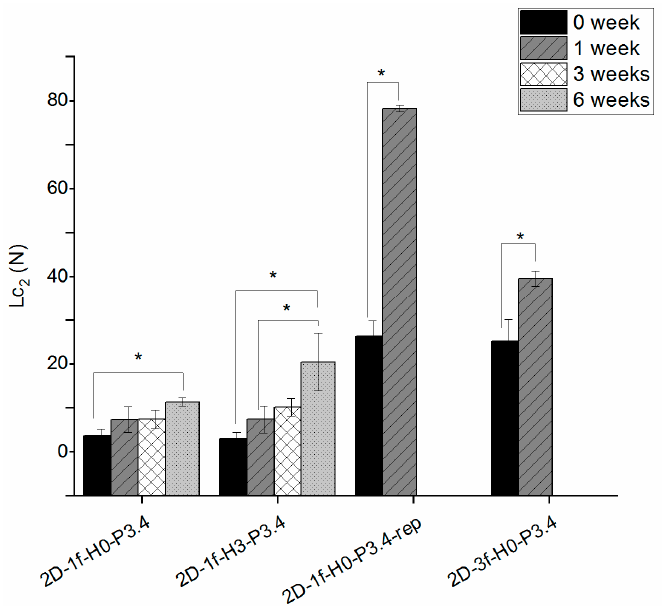
Figure 1. Critical load L c2 at different time points, from scratch tests on 2D coatings deposited on CoCrMo discs. * indicates a statistically significant difference between groups.